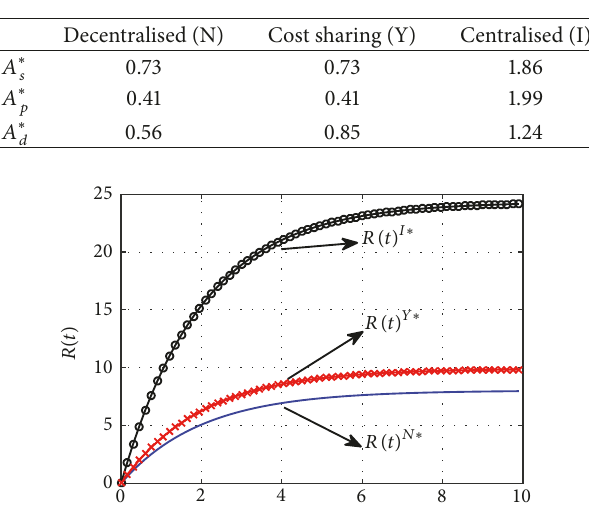
Table 2: Optimal strategies in supply chain systems.